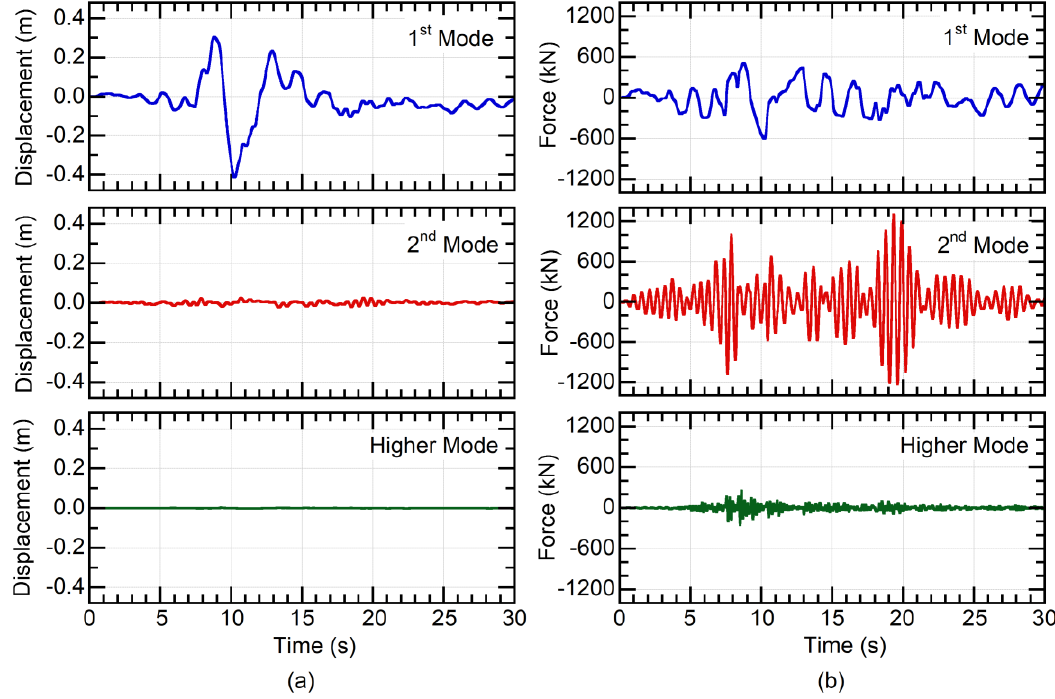
Figure 12. Comparison of modal response of Model-14 at level Z 14 (Art-S09, 100%): ( a ) relative displacement and ( b ) restoring force.